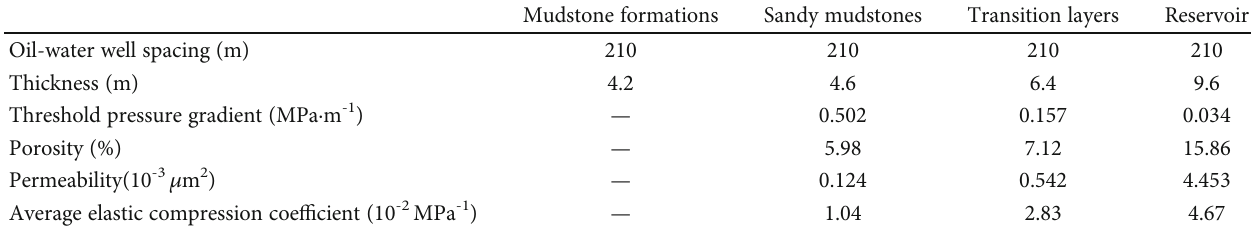
Table 5: Average value of the physical parameters of an actual reservoir.